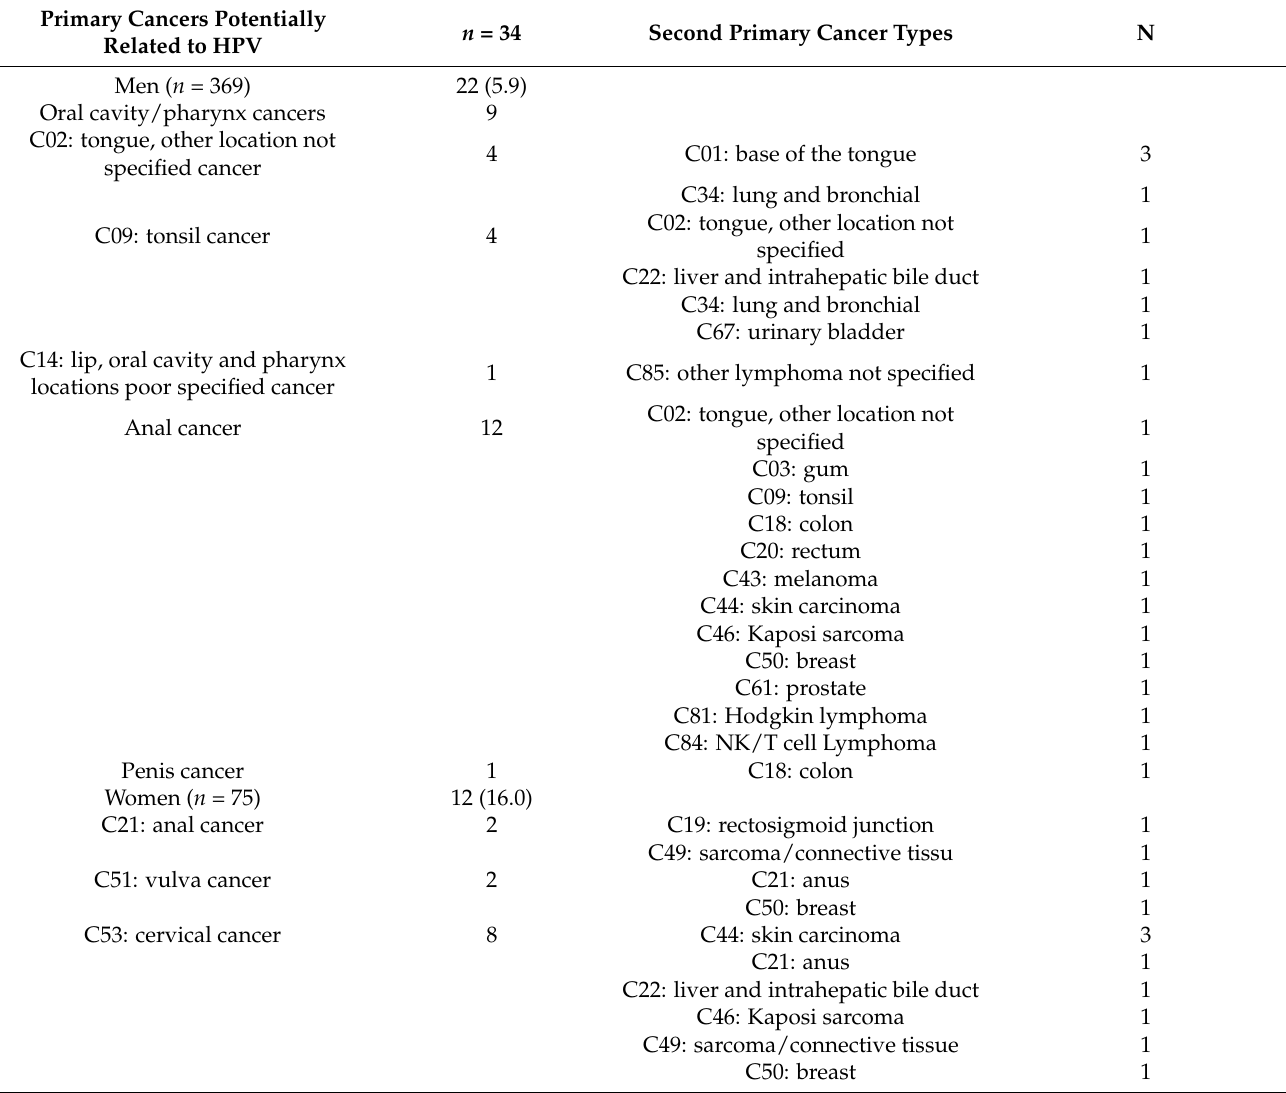
Table 2. Second primary cancer types after a first primary cancer that was potentially related to HPV in men and women living with HIV in the French Dat’AIDS